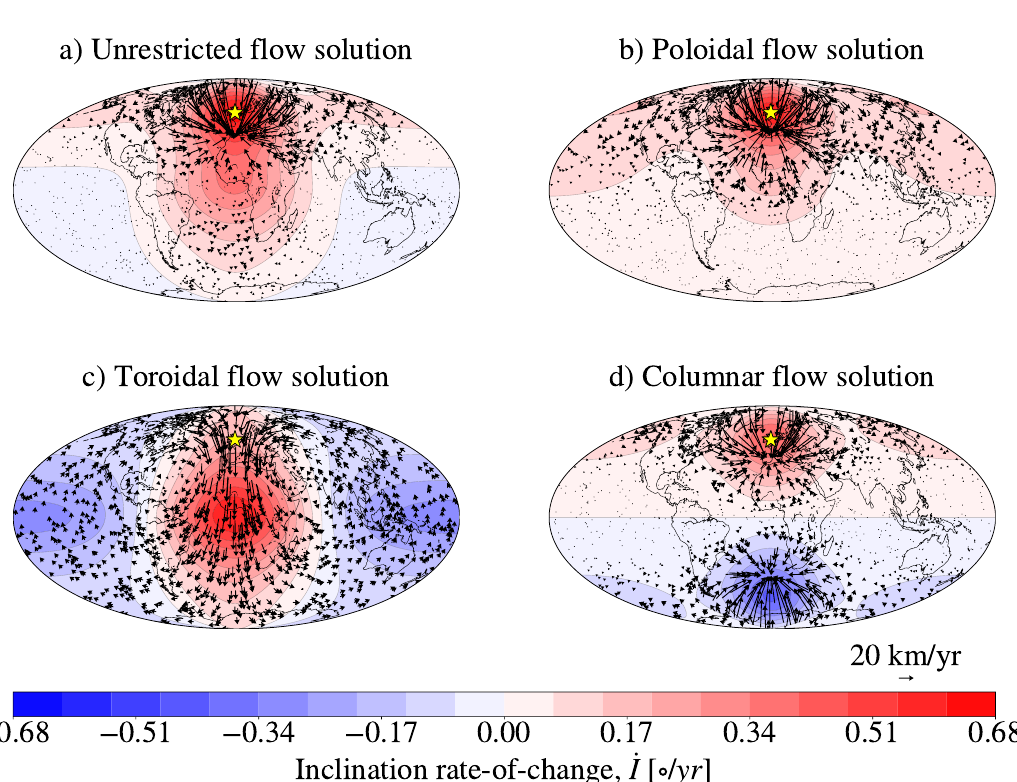
Figure 4. Optimal flows and global ˙ I for the solutions optimising ˙ I at Leeds for T 0 = 13 km/y and the same axial dipole background magnetic field as for the results reported in Figure 3. Shown are the solutions for unrestricted ( a ), poloidal ( b ), toroidal ( c ) and columnar ( d ) flow